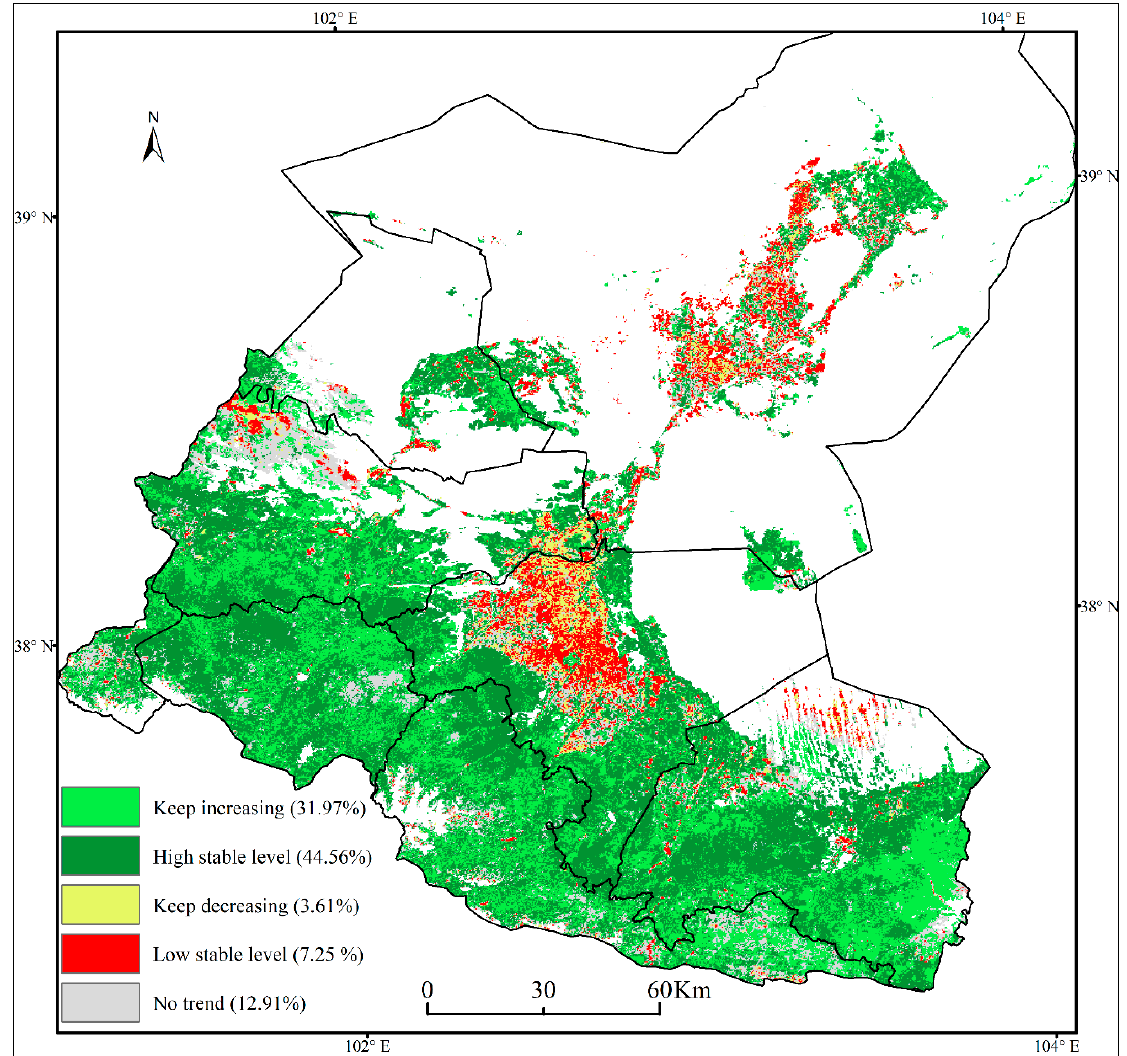
Figure 7. Future status of vegetation changes in the Shiyang River Basin. The proportion of each status is shown in the item of the legend.